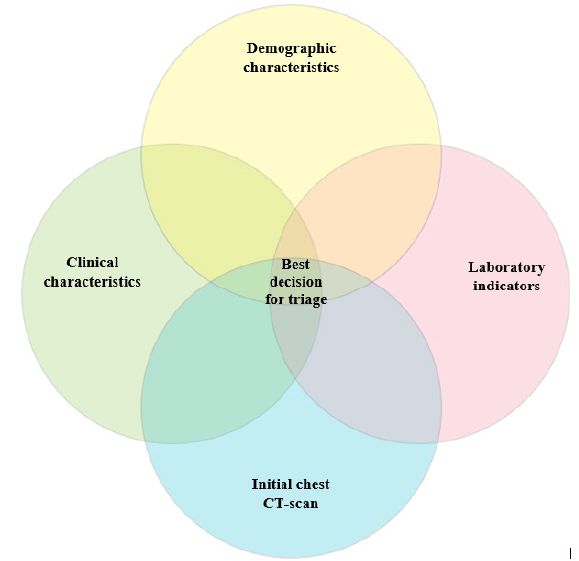
Figure 3. Venn diagram of best decision for final triage in COVID-19